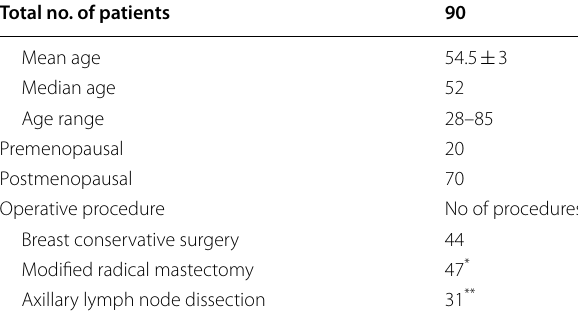
Table 2 Patients demographics